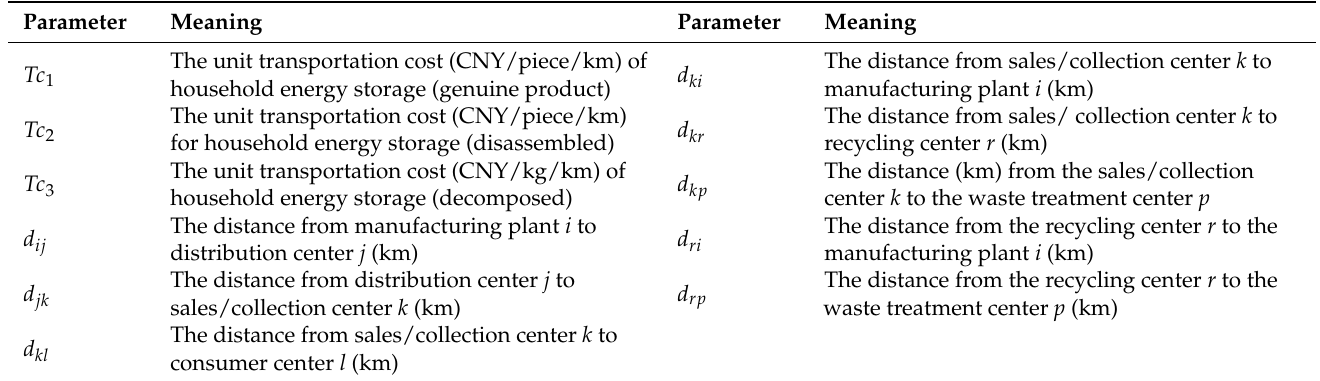
Table 8. Parameters of the distance correlation of each point.